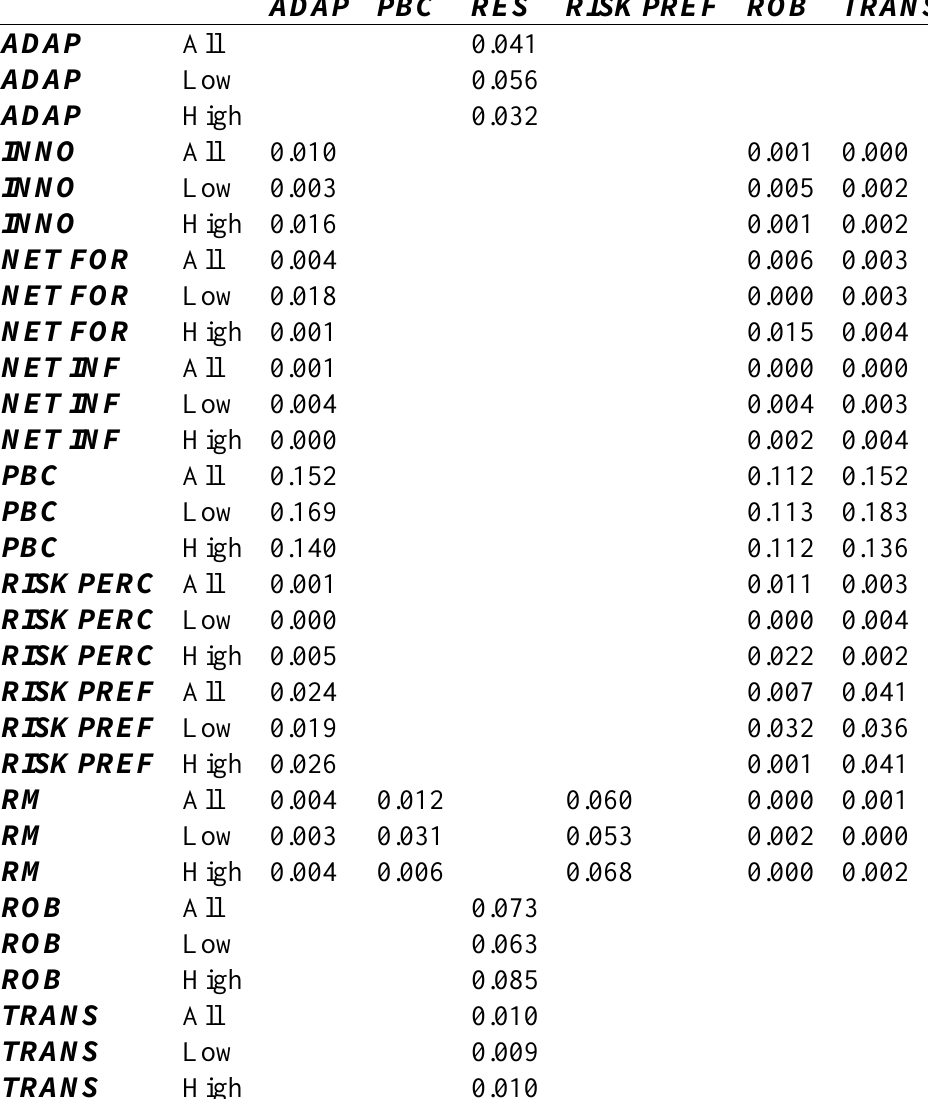
Table A1.6. f 2 statistics of the structural model